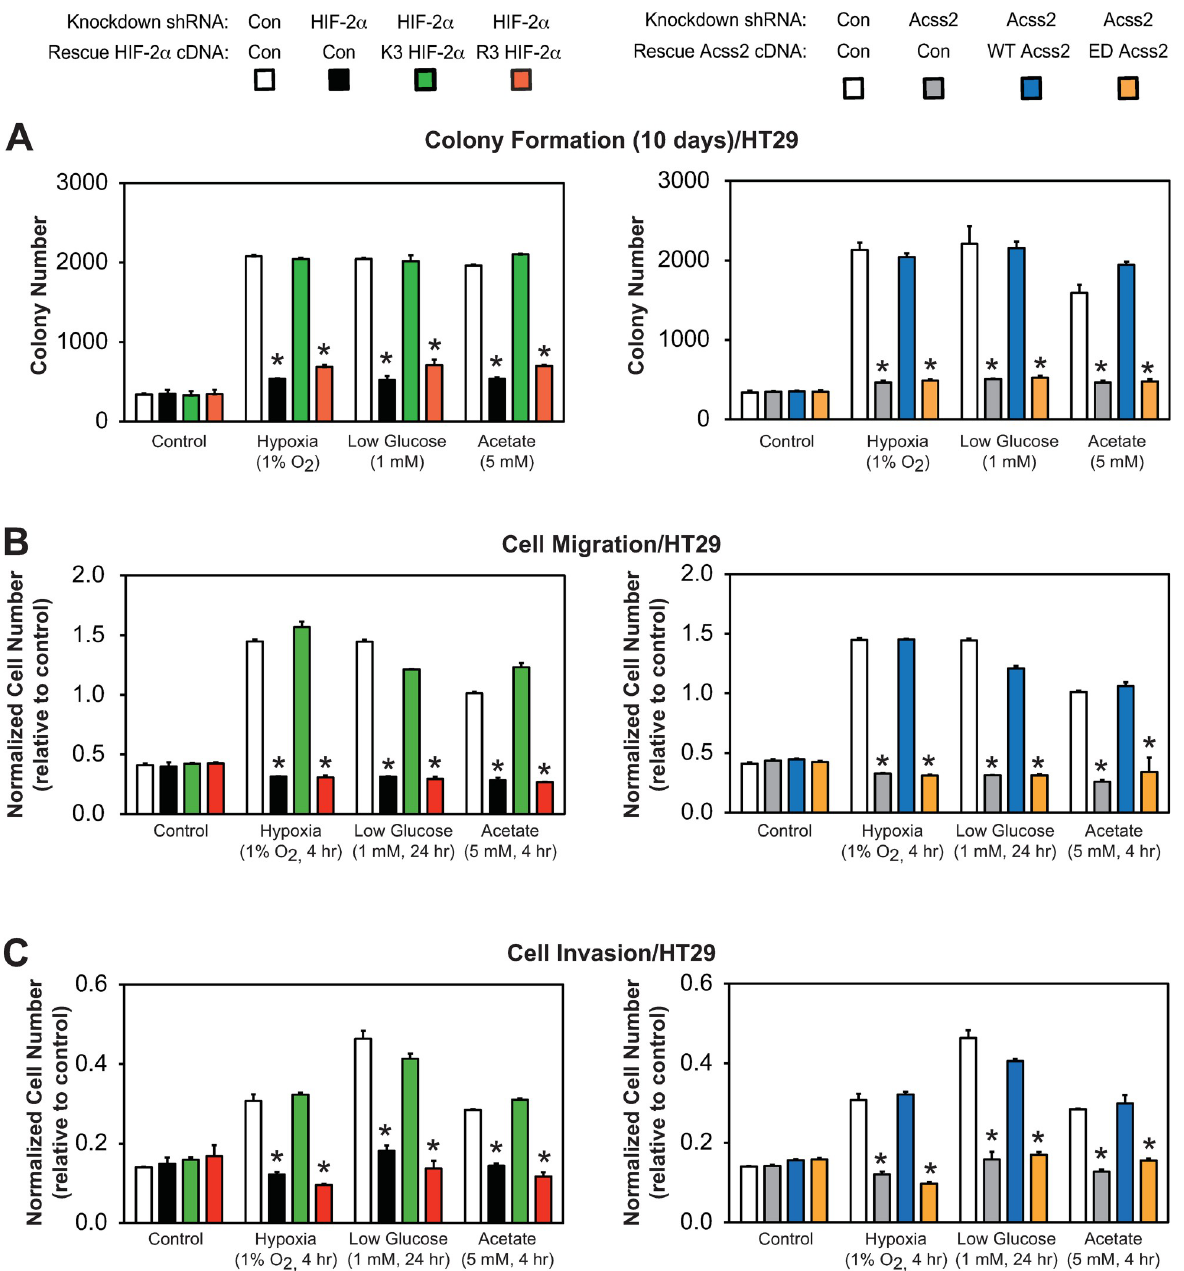
Fig 8. Acss2/Cbp/HIF-2 α regulates HT29 tumor cell properties. (A) Colony formation, (B) Cell migration, or (C) Cell invasion after ten days of stably transformed control or HIF-2 α knockdown HT29 cells rescued with wild-type (K3) or arginine-lysine substituted mutant (R3) HIF-2 α (left side), or stably transformed control or Acss2 knockdown HT29 cells rescued with wild-type (WT) or cytosol-restricted mutant (ED) Acss2 (right side). Cells were exposed to control (21% O 2 , 25 mM glucose), hypoxic (1% O 2 ), or low glucose (1 mM) conditions, or were supplemented with acetate (5 mM) (n = 8/treatment/day). Comparison of samples within a given condition on the day of interest for each experiment (colony formation, cell migration, cell invasion) was performed by one-way ANOVA followed by Dunnett’s multiple comparisons test using control shRNA knockdown/control rescue as reference with decreased samples noted ( � , P < 0.05). Values indicated are means with SD.